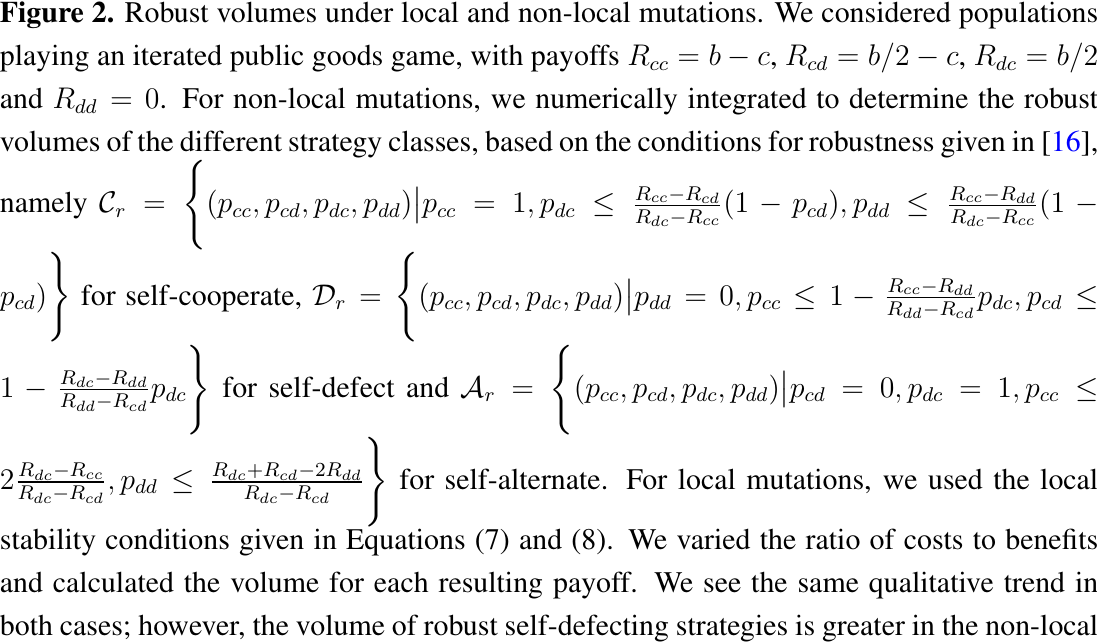
= b − c , R = b/ 2 − c , R = b/ 2 cc cd dc